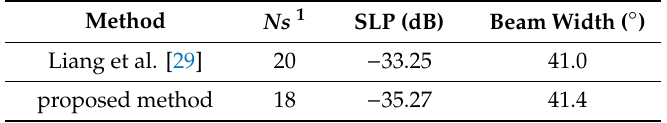
Table 2. Comparisons of flat-top BP synthesis results among the proposed method and the existing existing methods.